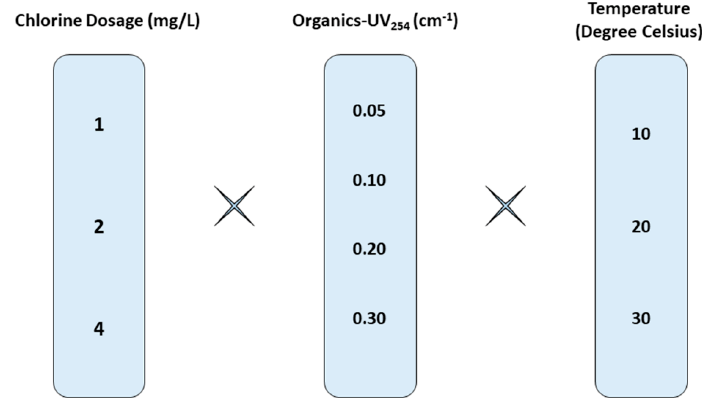
Figure 2. Matrix for the test conditions.